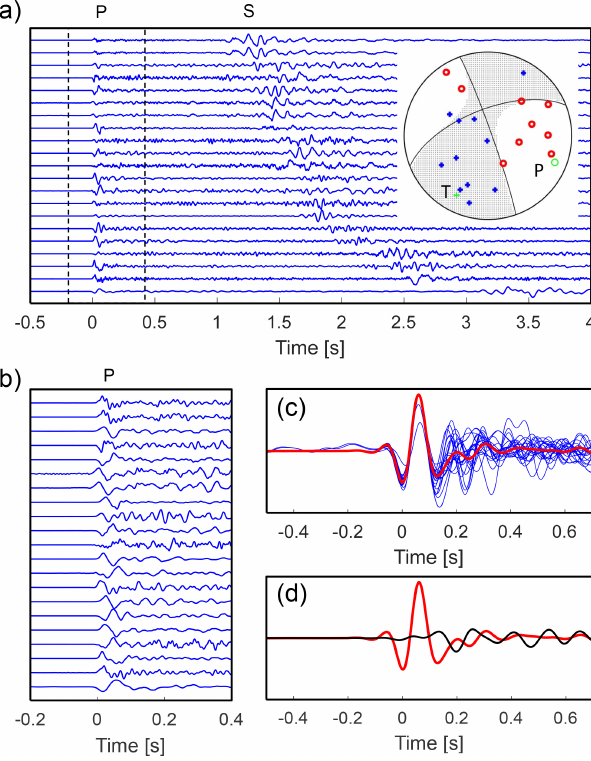
Figure 4. Example of the MT inversion of the earthquake on 24 May 2014 at 16:14:30UTC with M L 2.1. (a) Whole velocity records; (b) window with aligned P waves; (c) the common wavelet (red line) together with the P-wave traces at individual stations (blue lines); (d) the common wavelet represented by the first principal component (red line) and noise in waveforms represented by the second principal component (black line). The polarities of the P- wave in panel (c) are switched to be consistent with the polarity of the common wavelet. The inset in plot (a) shows the focal mecha- nism and positions of stations on the focal sphere (red circles mark negative polarities, and blue plus signs mark the positive polarities).